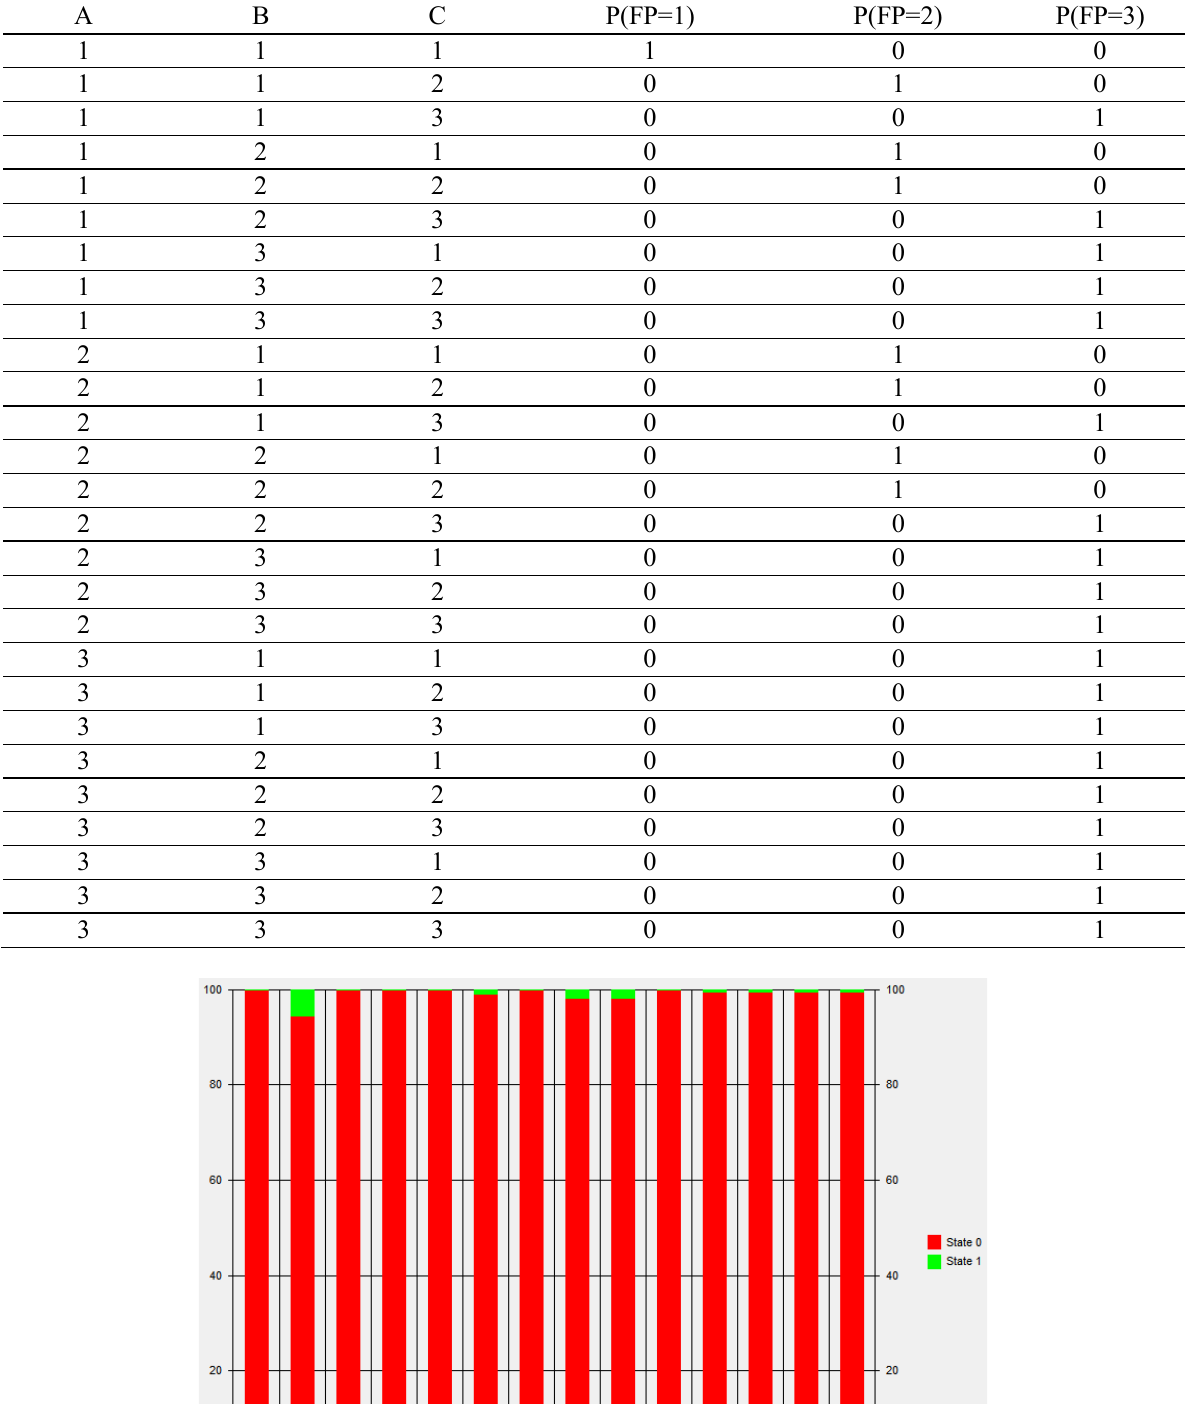
Table 15. States related to node FP